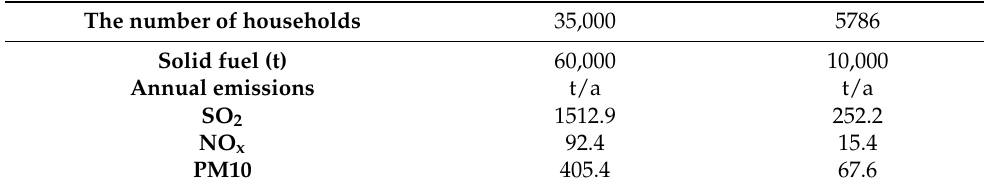
Table 15. Annual emissions reduction in tones for different pollutants during 150 days for 35,000 and 5786